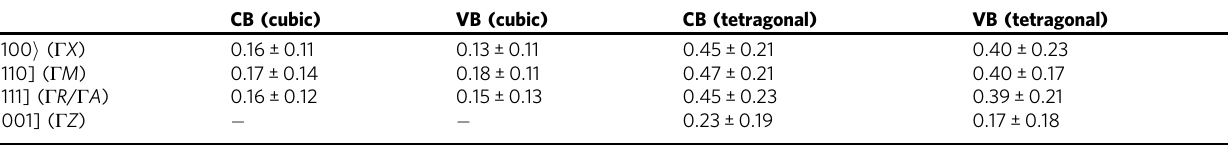
Table 2 Computed Rashba parameters